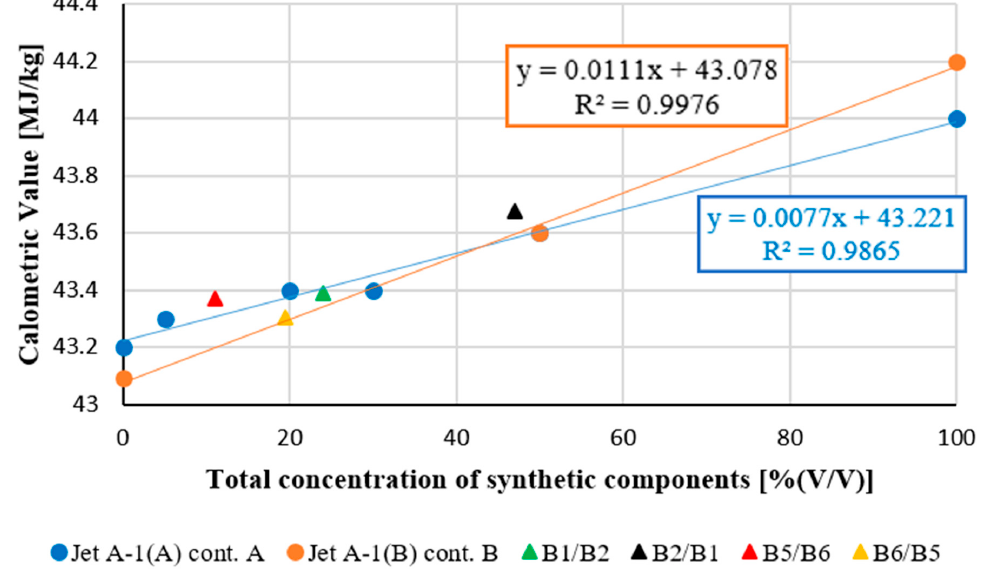
Figure 5. Dependence of calorific value on the total content of synthetic components A and B. The calorific value is the total effect of enthalpy of all reactions that make up the combustion process. The addition of the synthetic component A or B changes the chemical structure of the fuel; mineral Jet A-1 fuel consists of about 1000 hydrocarbons, whereas